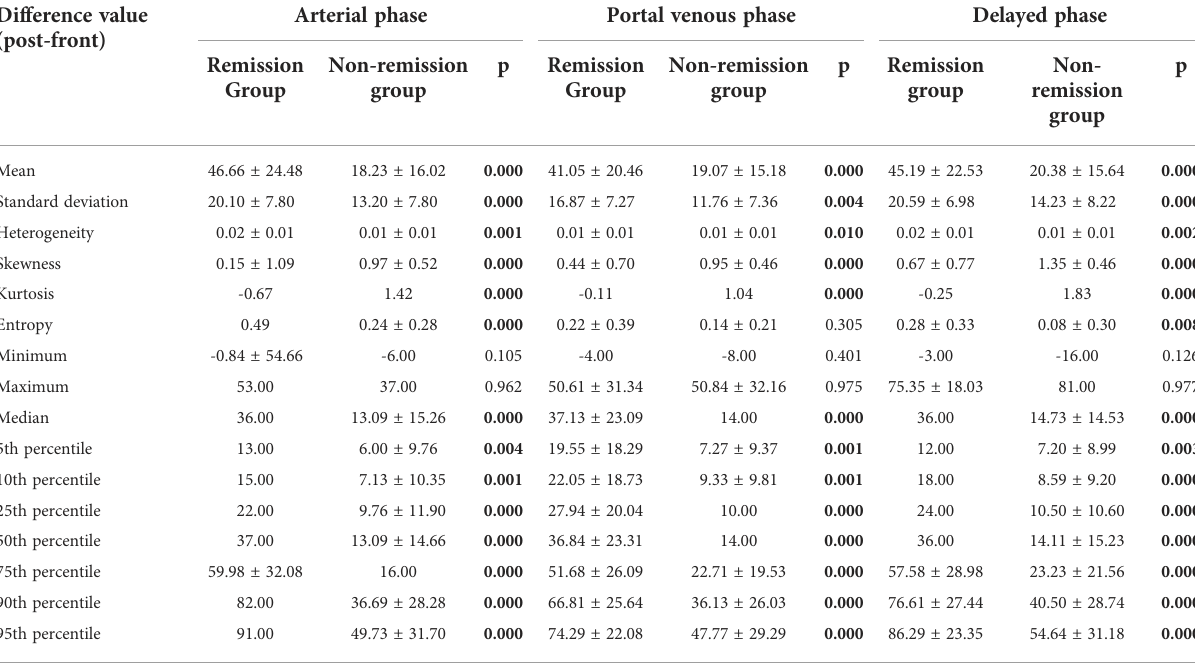
TABLE 2 Differences in three-phase grayscale histogram parameter difference values between remission group and non-remission group. Difference value